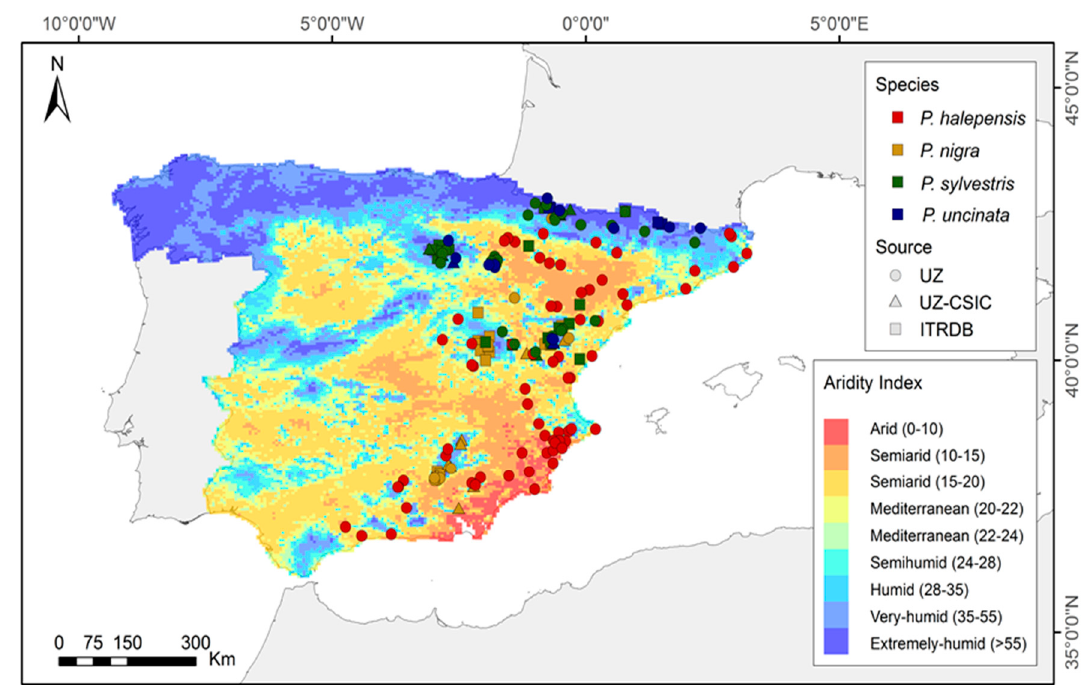
Figure 1. Sampling points location map.